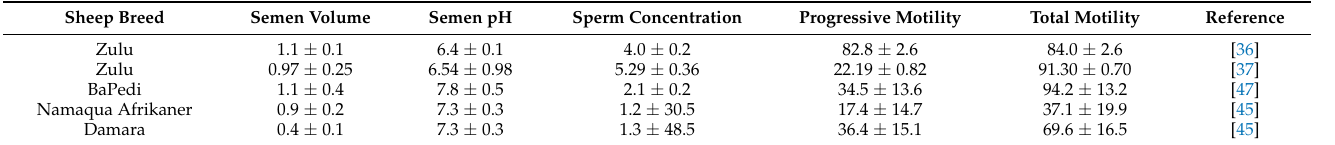
Table 10. Semen characteristics of South African indigenous sheep